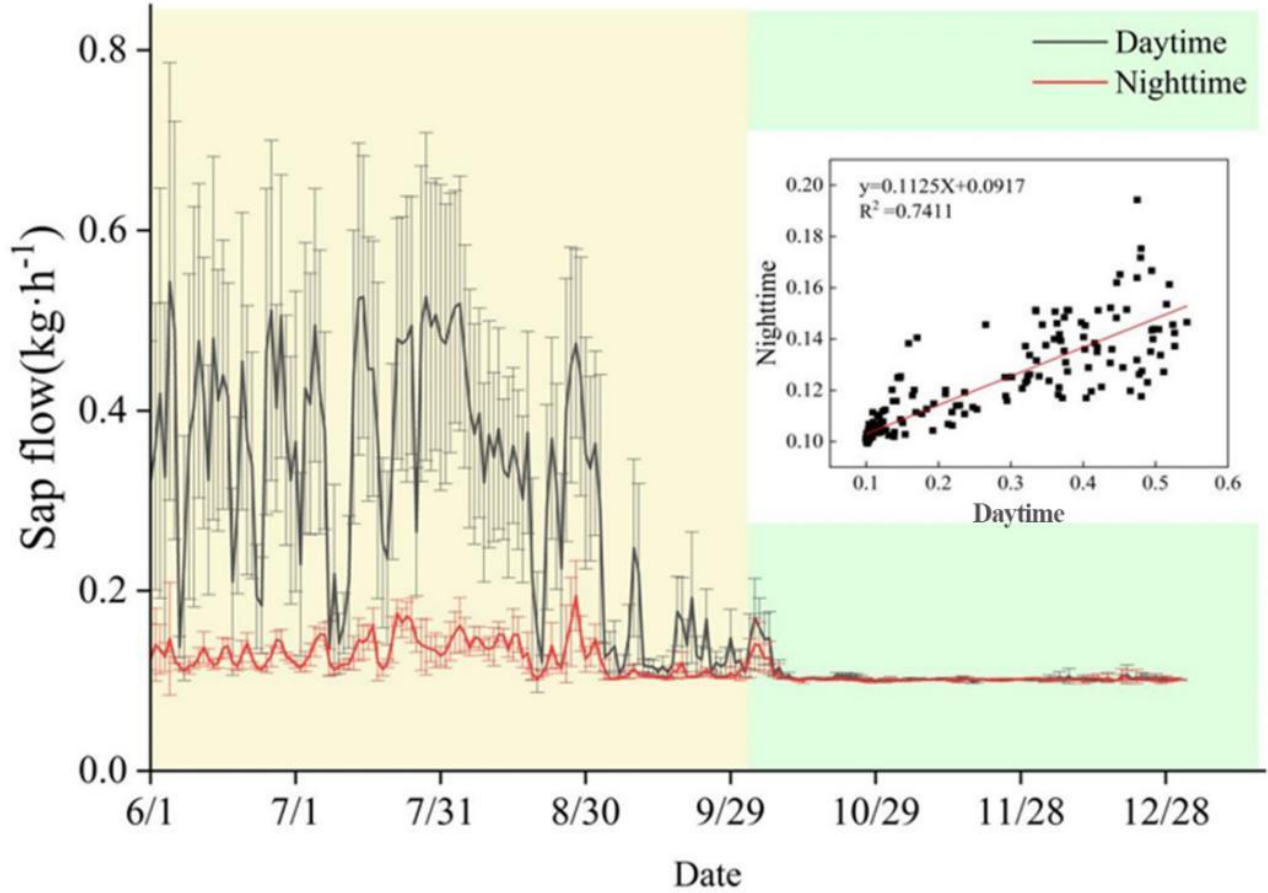
Figure 8. The variation in sap flow of golden pears in the day and night during the whole observation period. In the figure, the light orange areas represent the growing season, and the green areas represent the non-growing season. The black line represents the daytime sap flow value, and the red line represents the nighttime sap flow value. The right panel is a linear regression of daytime and nighttime sap flow over the entire study period. Significance level p < 0.05. Table 4. The difference between the mean sap flow during the day and night of each month.